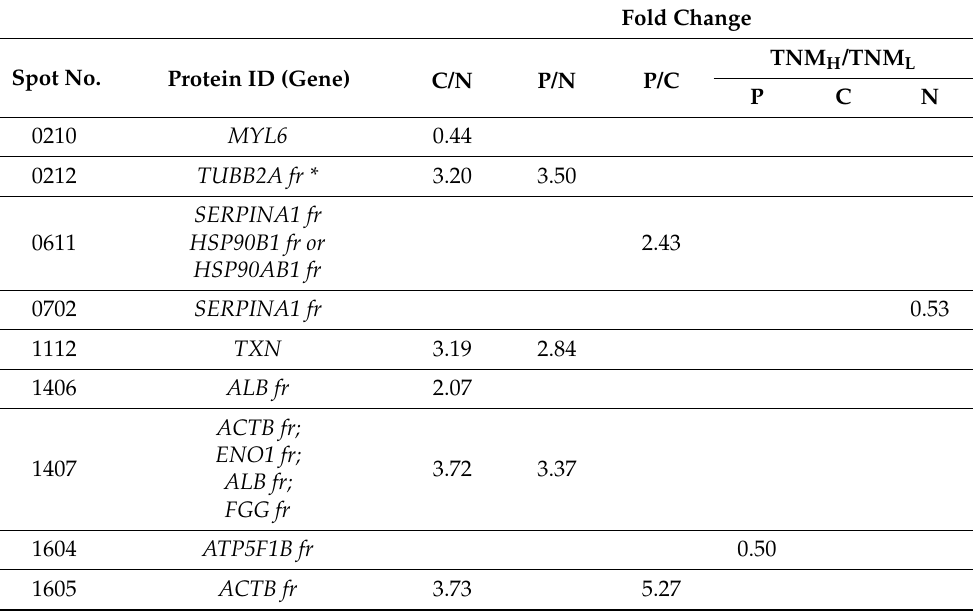
Figure 1. Proteomic analysis of patient colorectal tissue obtained from non-involved (N), peripheral (P) and central (C) part of the tumor. Comparative analysis of the spots was performed with the PDQuest software. Differentially expressed spots with a change of 1.5-fold or more are shown (Wilcoxon signed rank test, p < 0.05). Identification of differentially expressed proteins are listed in Table 2. Table 2. Identification of differentially expressed proteins in tumor tissue from CRC